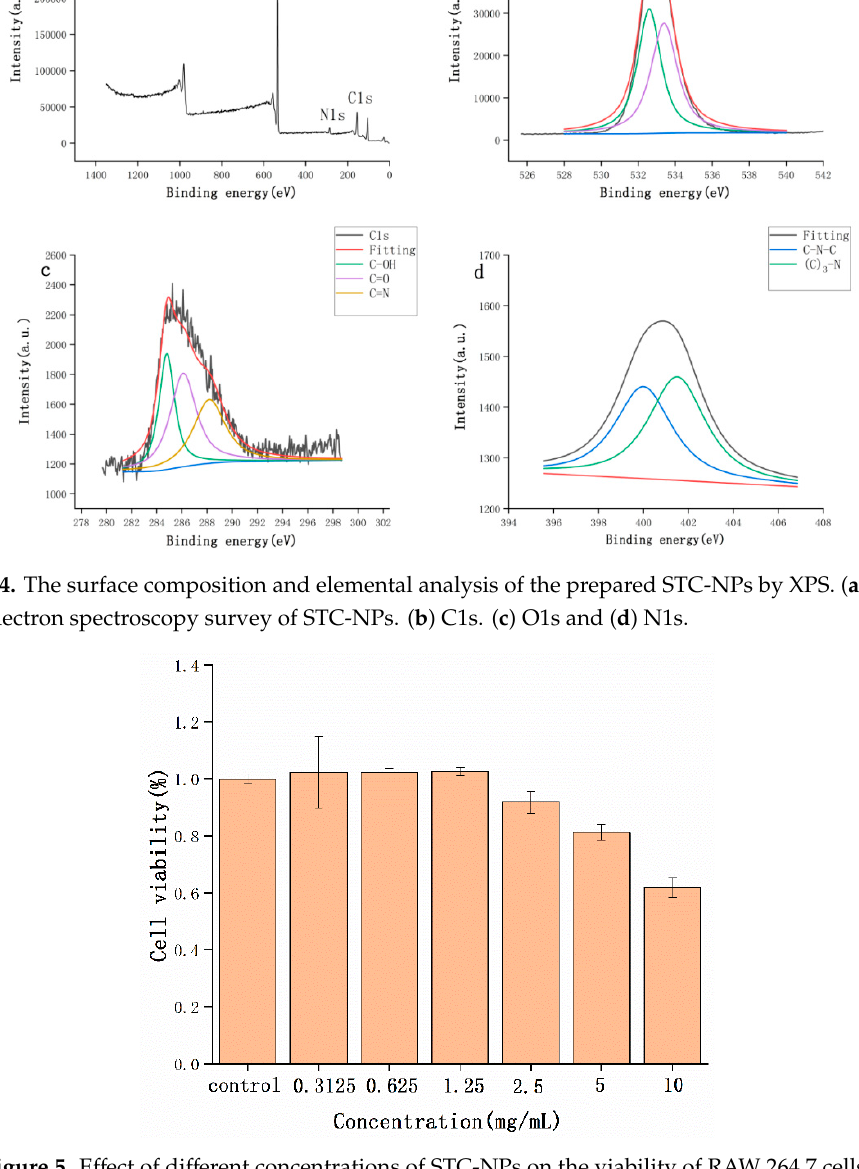
Figure 6. Graphs of haemostatic time in mouse tail amputation and liver scratch models. ( a ) Tail amputation ( n = 8) and ( b ) liver scratch ( n = 8) models treated with normal saline (NS), haemocoagulase (HC), and high (H), medium (M), and low (L) doses of STC ‐ NPs (16.67, 8.33, and 4.17 mg/kg, respectively). ** p < 0.01 and * p < 0.05 compared to the control group ( n = 8). 2.5. Haemostatic Effect of STC ‐ NPs Compared to the NS group (9.07 ± 0.67 min), the HC group (2.33 ± 0.31 min) and the high ‐ , medium ‐ and low ‐ dose STC ‐ NPs groups (2.75 ± 0.62, 1.82 ± 0.26, 3.59 ± 0.41 min, respectively) significantly ( p < 0.01) reduced tail bleeding time (Figure 6a). Liver bleeding time was the longest in the NS group (7.93 ± 0.55 min). Figure 6b shows that both the positive group (2.68 ± 0.39 min) and the STC ‐ NP groups (H 2.46 ± 0.29, M 2.08 ± 0.27, L 3.61 ± 0.33 min) significantly ( p < 0.01) reduced liver bleeding time compared to the normal saline group. These results indicated that the STC ‐ NPs had a significant haemostatic effect. 2.6. Effect of STC ‐ NPs on the Coagulation System